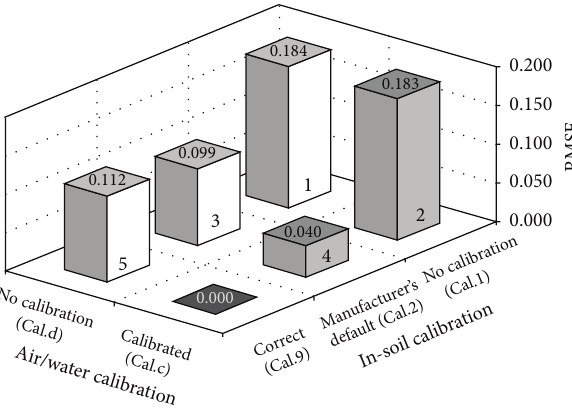
Figure 7: Effect of different calibration schemes on the RMSE for Scenarios 1–5, compared to the control